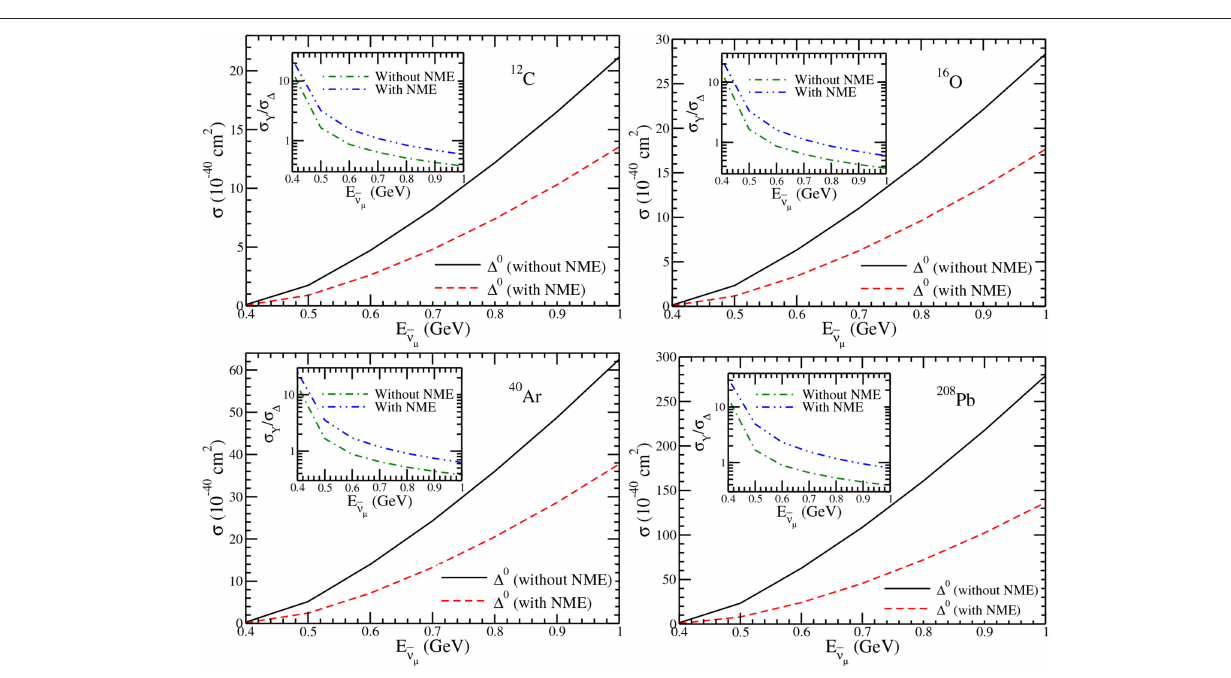
Frontiers in Physics |